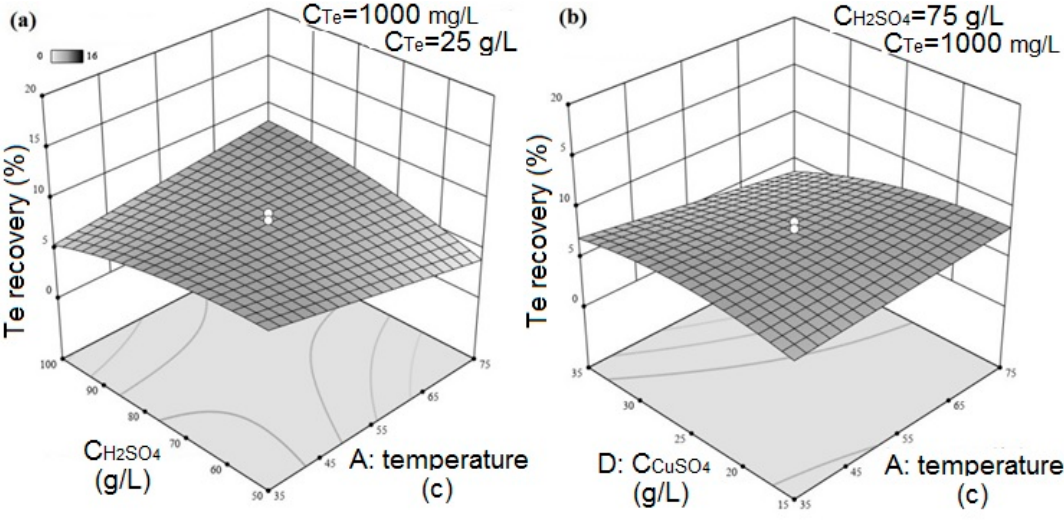
Figure 6. Response surface graphs for interactions of parameters of Te (IV) cementation by solid copper. ( a ) Effect of H 2 SO 4 concentration and temperature; ( b ) Effect of Temperature and Cu concentration.